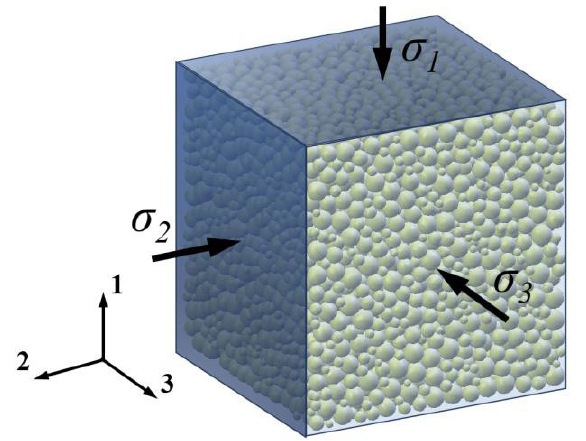
Figure 3: Model set-up for numerical simulations of triaxial test.